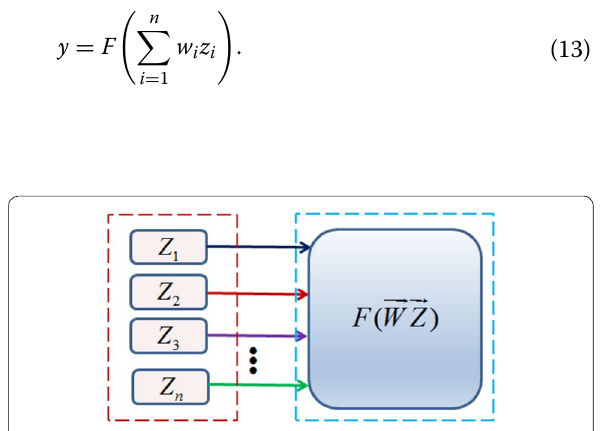
Figure 3 A schematic neuron model